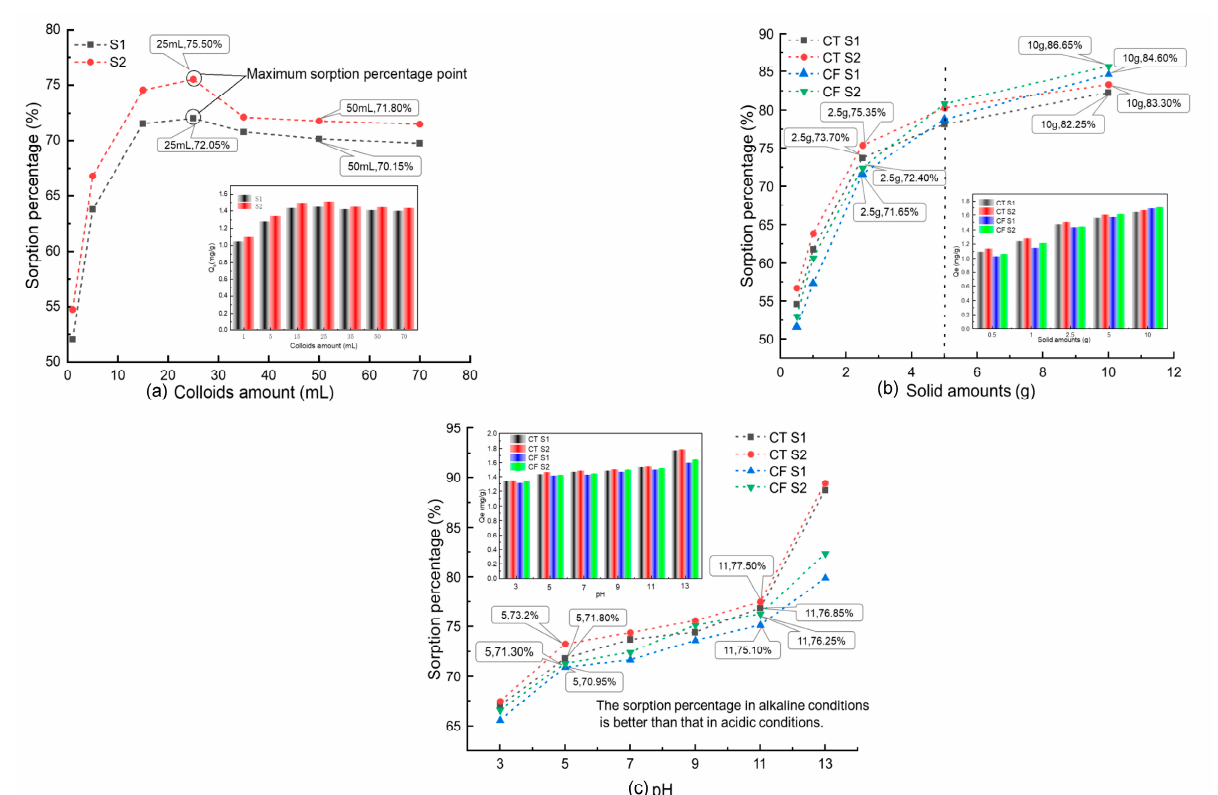
Figure 2. Influence of different parameters on the sorption of Sr by CT and CF: ( a ) colloid amount, C [Sr]initial = 20 mg/L, solid content = 2.5 g, pH = 7.0, t = 4320 min; ( b ) solid content, C [Sr]initial = 20 mg/L, colloid amount = 35.7 mL, solid content = 2.5 g, pH = 7.0, t = 4320 min; ( c ) pH, C [Sr]initial = 20 mg/L, colloid amount = 35.7 mL, solid content = 2.5 g, t = 4320 min.